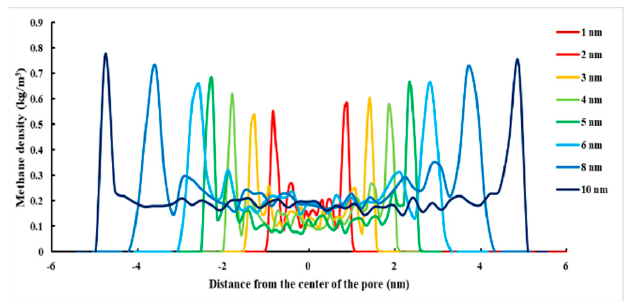
Figure 6. Comparison of the density of methane at different pore sizes.